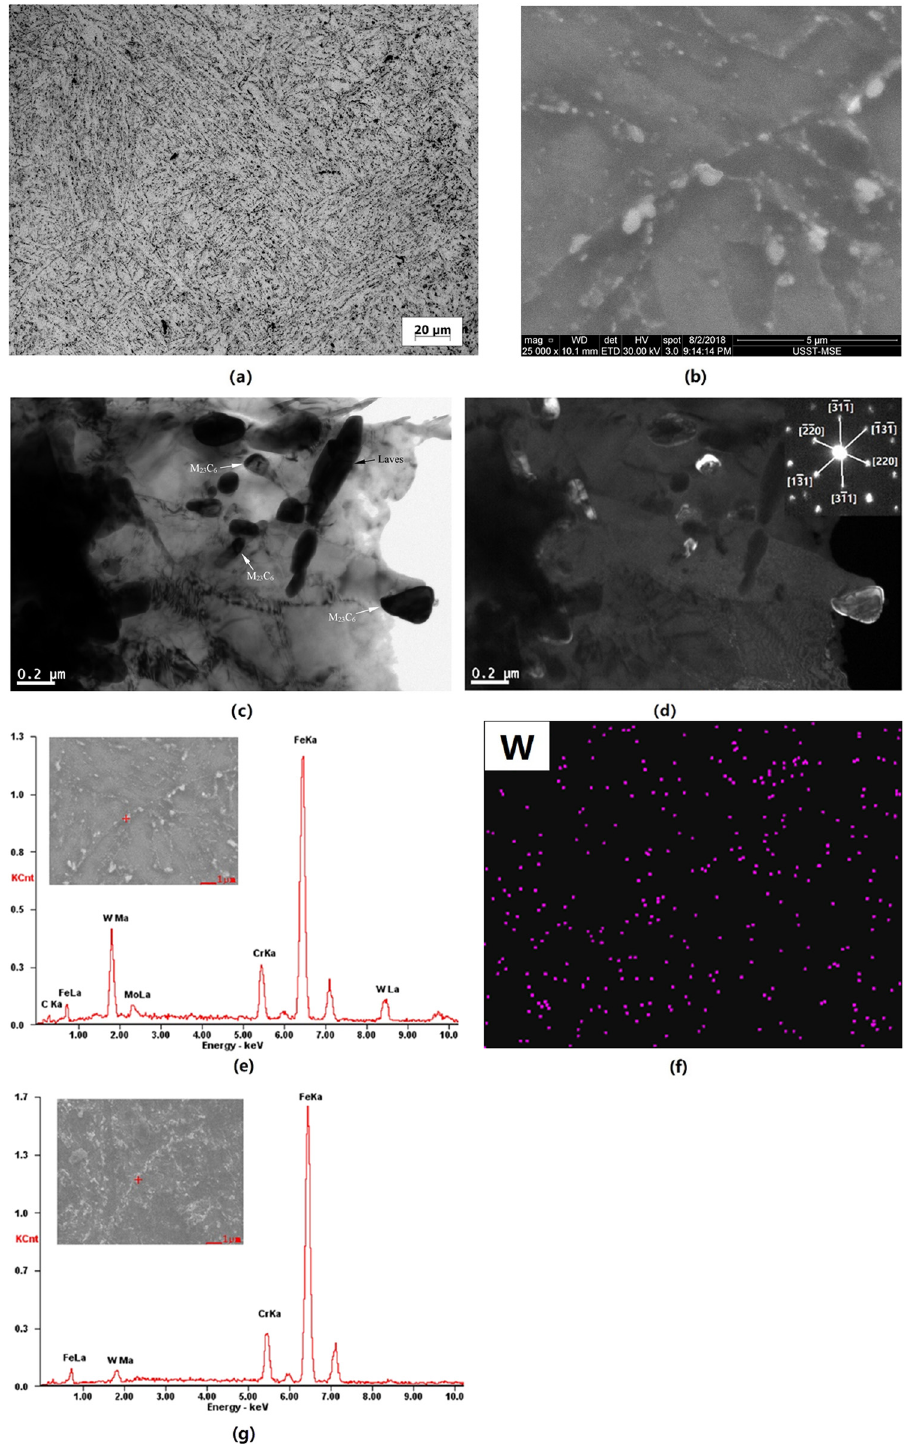
Figure 3: ( a ) OM image, ( b ) SEM image, ( c ) TEM bright - fi eld image, ( d ) TEM dark - fi eld image and SAED of M 23 C 6 , ( e ) SEM – EDS result of P92 steel after 650°C – 4,000 h aging, ( f ) SEM – EDS mapping image of W in P92 steel after 650°C – 4,000 h aging, and ( g ) SEM – EDS result of P92 steel after 650°C – 1,000 h